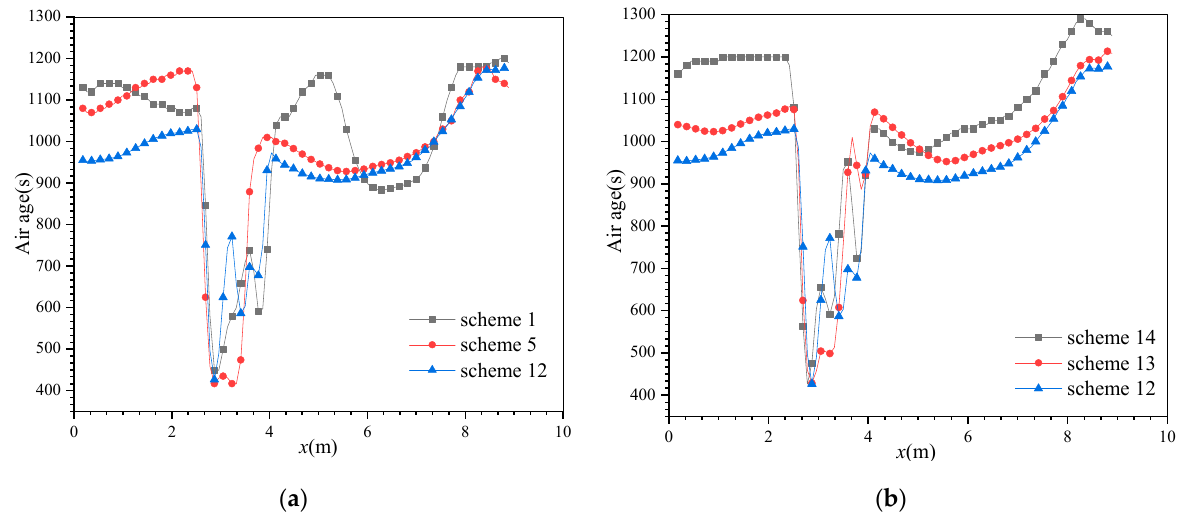
Figure 13. Comparison of air age in different layout schemes ( z = 1.6 m and y = 3.065 m). ( a ) Air age on the working path at three layout schemes. ( b ) Air age of three export heights on the working path.